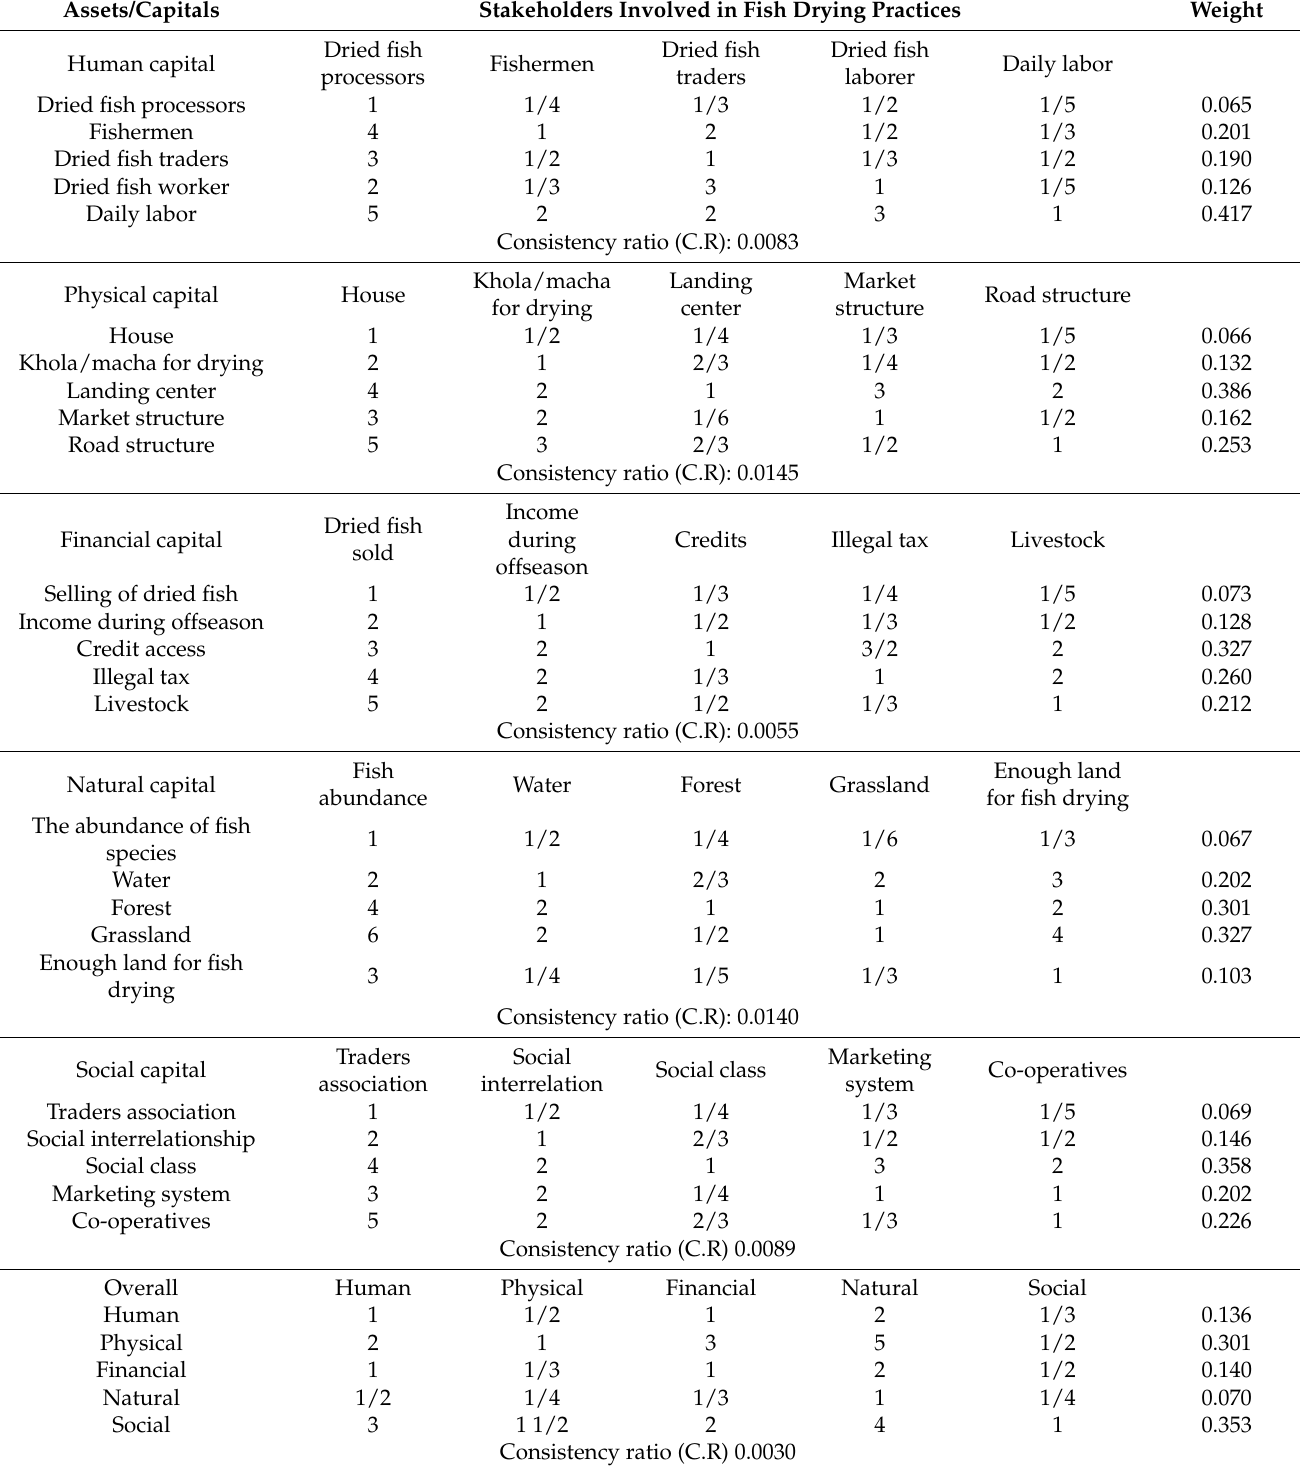
Table 6. A pair-wise comparison matrix for assessing the relative importance of different criteria for resilience assessment of communities involved in fish drying practices to livelihood vulnerabilities in the study areas (numbers show the row factor rating close to the column